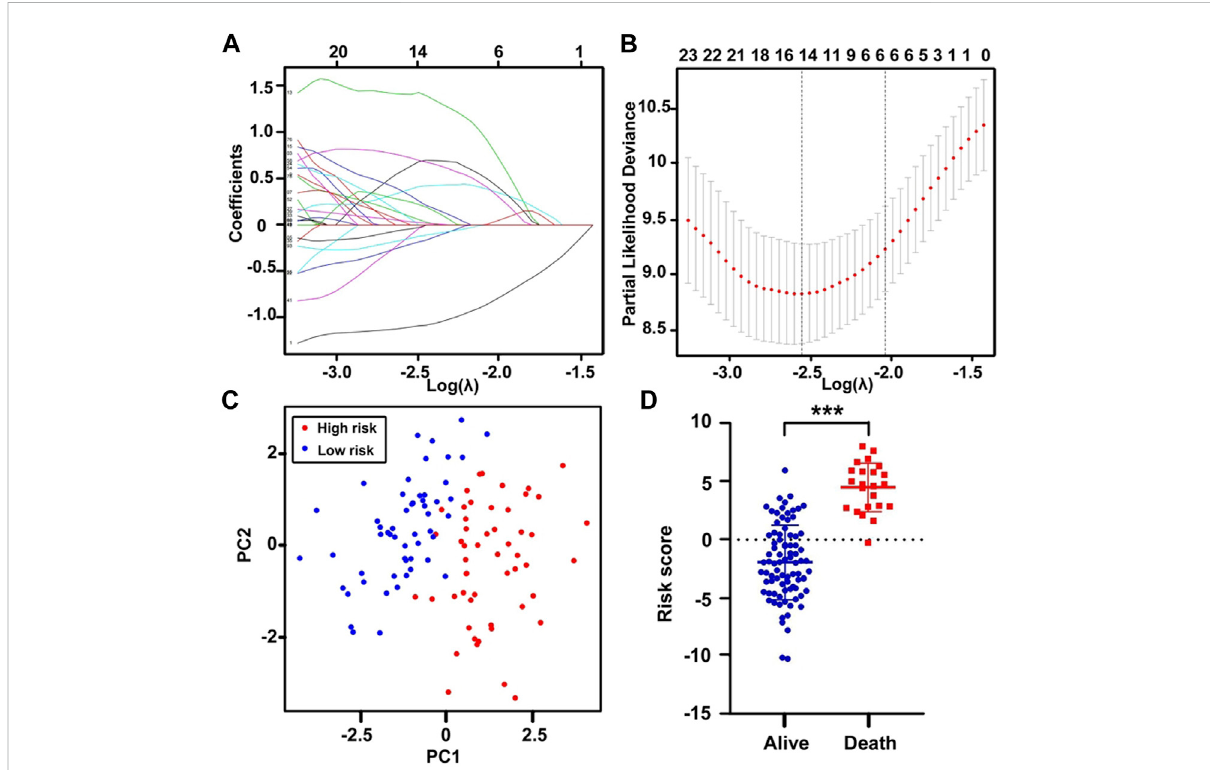
FIGURE 2 Construction of the SE-related prognostic model. (A) The LASSO coef fi cient values at various levels of penalty; each curve represents an SE- gene. (B) The con fi rmation of the best lambda value by LASSO Cox regression analysis. (C) Principal component analysis (PCA), red dots correspond to high-risk patients, and blue dots correspond to low-risk patients. (D) The scatter plot of the survival status of CLL patients based on the 9-gene model using the t -test. *** p <